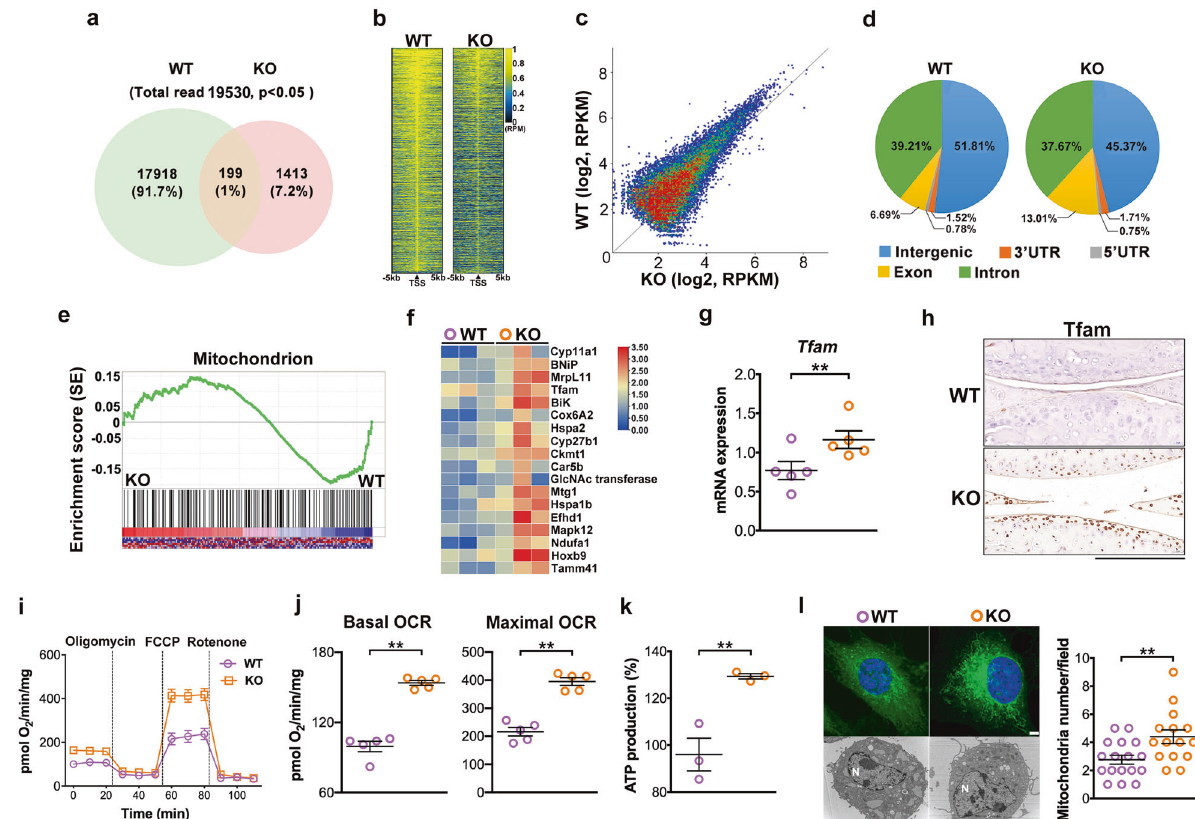
Fig. 5 ChIP-seq analyses of H3K27me3 in chondrocytes. Venn diagram showing the overlap of H3K27me3 peaks between UtxKO and WT mice. Total numbers of H3K27me3-enriched binding sites and their relative proportions (%) are indicated. Note that UtxKO mice revealed fewer binding sites compared to WT animals ( a ). Heatmaps of ChIP-seq analyses showing H3K27me3 DNA occupancy within 5 kb upstream and downstream, respectively, of transcriptional start site (TSS) ( b ). Scatter plots shows H3K27me3 ChIP-seq signals distribution in UtxKO and WT ( c ), next to the relative distribution of H3K27me3 occupancy across genomic regions in chondrocytes of WT and UtxKO animals, respectively ( d ). Gene set enrichment analysis of H3K27me3 marks revealed signi fi cant enhancement mitochondrion in UtxKO cells ( e , f ). Data are calculated from three mice. Tfam mRNA expression ( g ), Tfam immunostaining ( h scale bar, 10 μ m) mitochondrial respiration pro fi les ( i ), basal and maximal oxygen consumption rates ( j ), ATP production ( k ), and mitochondrial mass as evidenced in MitoTracker Green staining (scale bar, 20 μ m) and electron transmission microscopy (scale bar, 200 nm) ( l ) in UtxKO chondrocytes were higher than in WT cells. Data are expressed as mean ± standard errors calculated from three to fi ve mice. * P < 0.05; ** P <